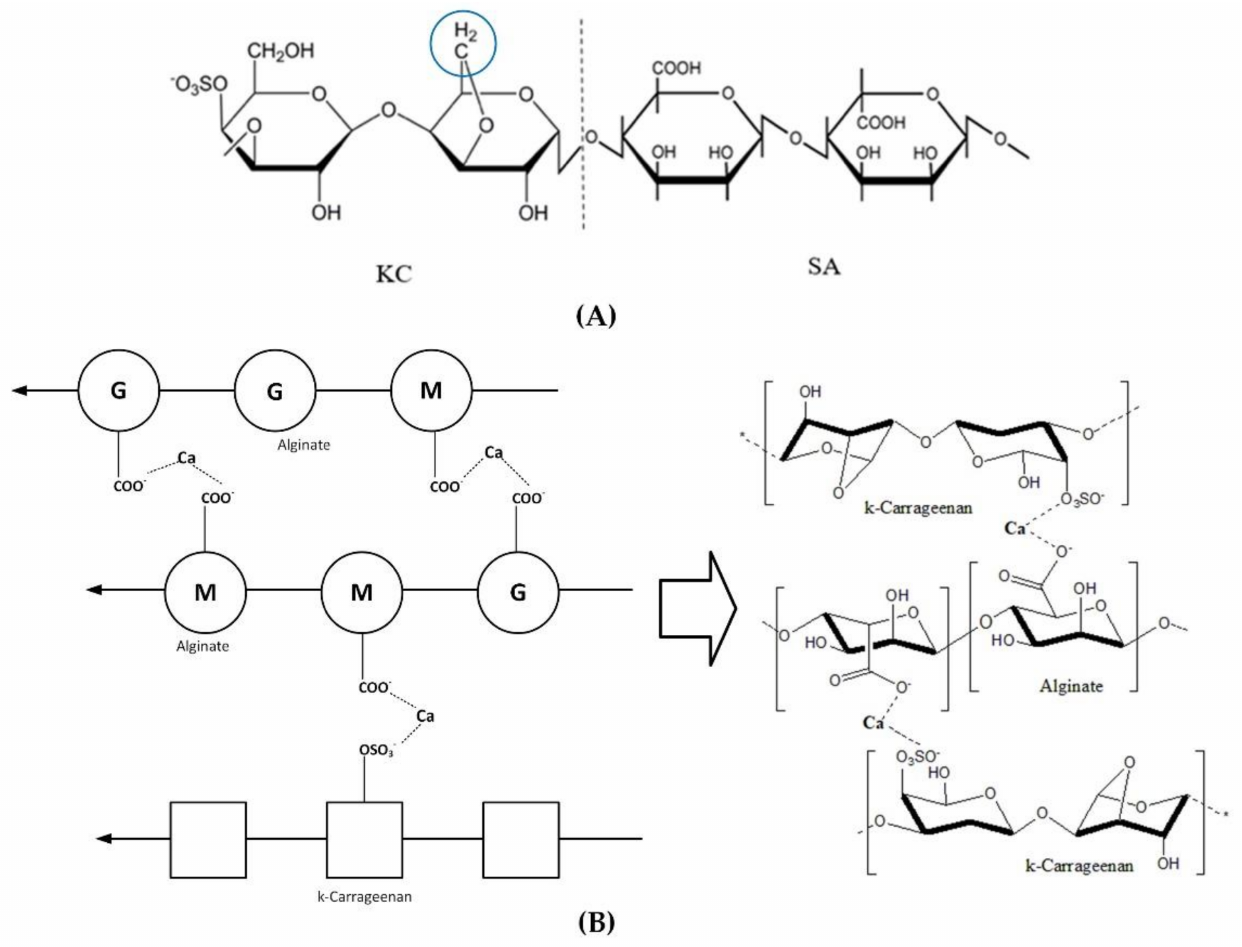
Figure 4. Scheme of ( A ) SA/KC film reaction, and ( B ) SA/KC interaction through Ca 2+